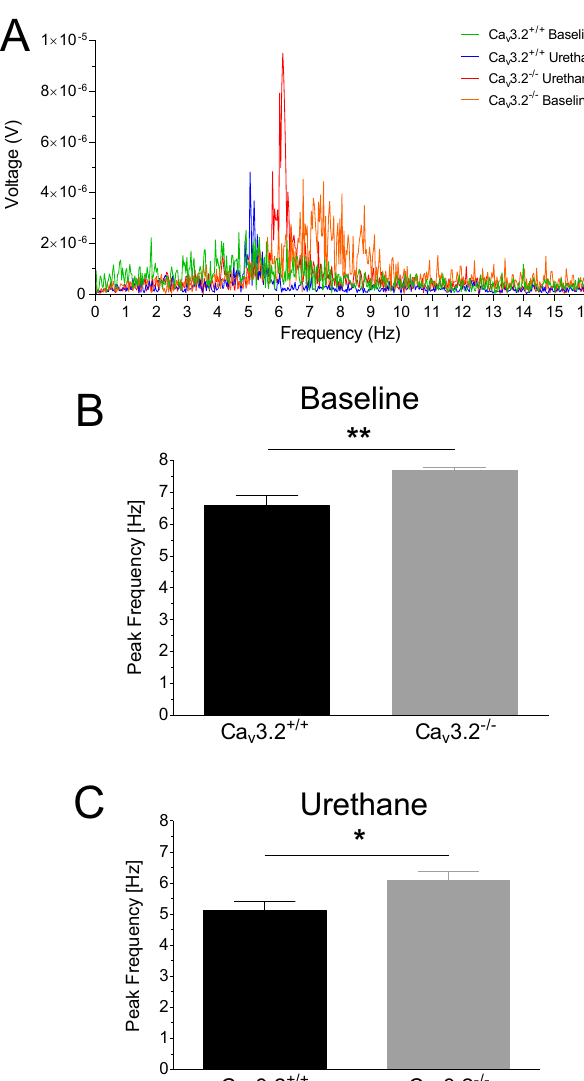
Figure 9. Altered theta architecture in Ca v 3.2 −/− mice. ( A ) Power spectrum density (PSD) plots obtained from representative 30 s EEG traces from baseline and post urethane states from both genotypes. ( B , C ) PSD plots from the baseline ( B ) and post urethane state ( C ) were analyzed for peak frequencies in the range of 0–16 Hz. Under both baseline and post urethane conditions, Ca v 3.2 −/− mice exhibited a significant increase in theta peak